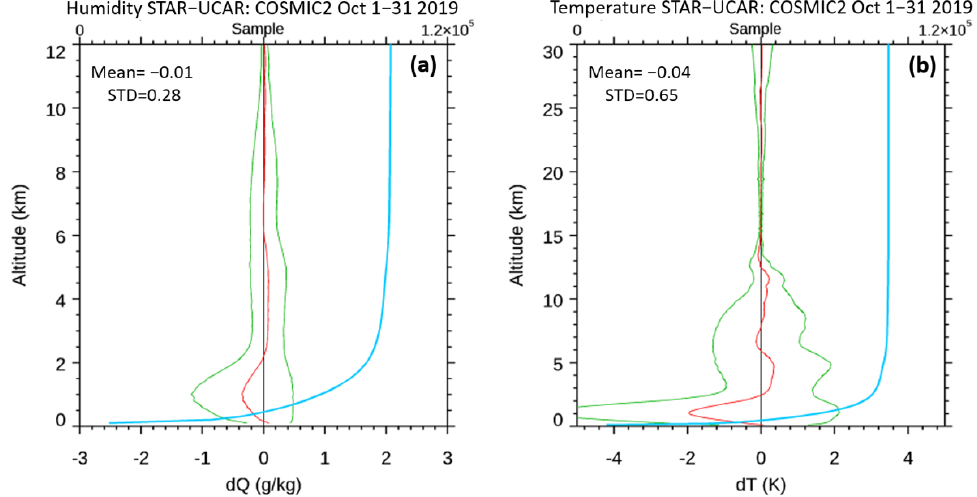
Figure 12. Monthly mean difference (red lines) +/ − standard deviation (green lines) for (STAR- UCAR) profiles of ( a ) specific humidity and ( b ) temperature. Light-blue lines show a sample number of averaged soundings.